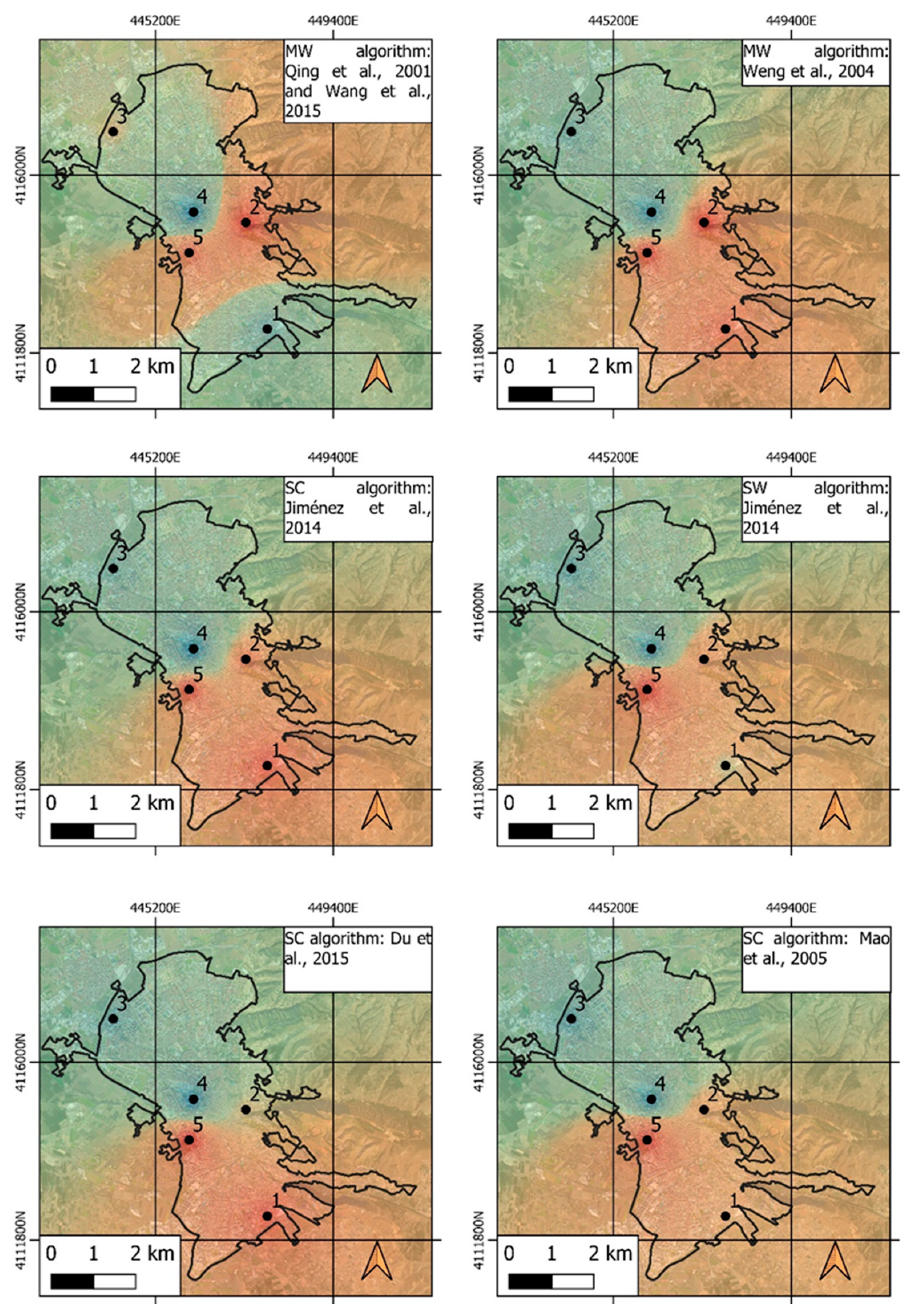
Figure 6. Annual mean LST obtained according to the different algorithms. For the delimitation of urban, suburban and green areas, the different structures, cov- erage and densities that the city presents were taken into account. The steps carried out for the selection of zones were: (1) Compilation of the city´s metadata based on the real coverage through high resolution images from Google Street View and Sentinel 2 satel- lites; (2) Compilation of the metadata regarding building density in the city based on in- formation from the National Institute of Statistics; (3) Selection and delimitation of zones.